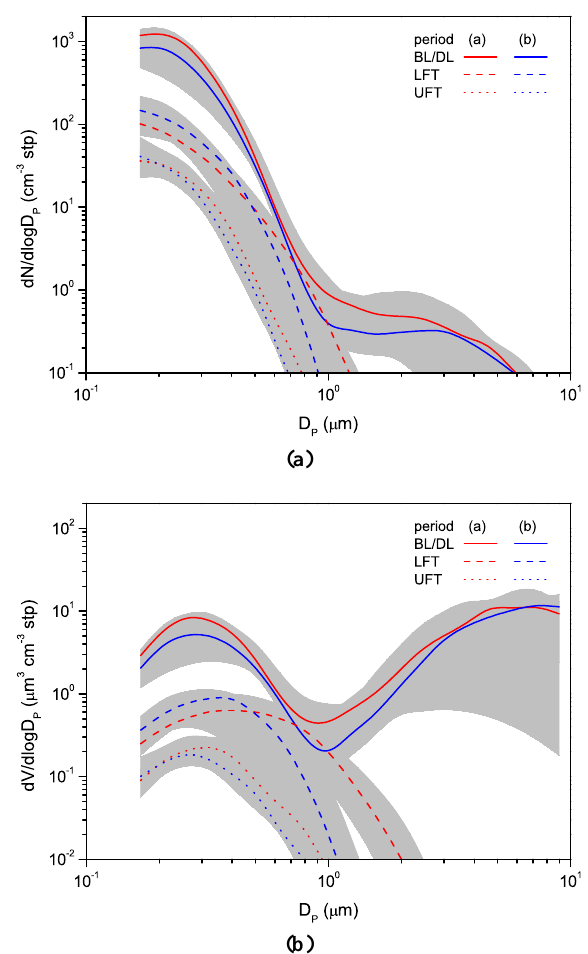
Fig. 6. Number size distributions (a) and volume size distributions (b) above all regions. Concentrations are given at standard temper- ature and pressure. The panels show measurements performed dur- ing horizontal flight legs within the boundary layer and decoupled layers (BL/DL), the lower free troposphere (LFT) and upper free troposphere (UFT). The red and blue lines show median values for periods (a) and (b) , respectively. The grey shade indicates the 1st and 3rd